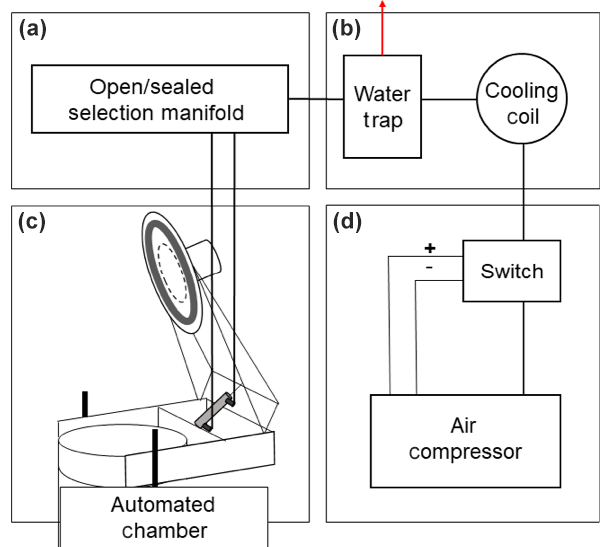
Figure 4. Illustration of the chamber pneumatic system that controls opening and closing of chambers. The red arrow denotes the tube to drain the water trap reservoir. Figure panel labels are defined in the main